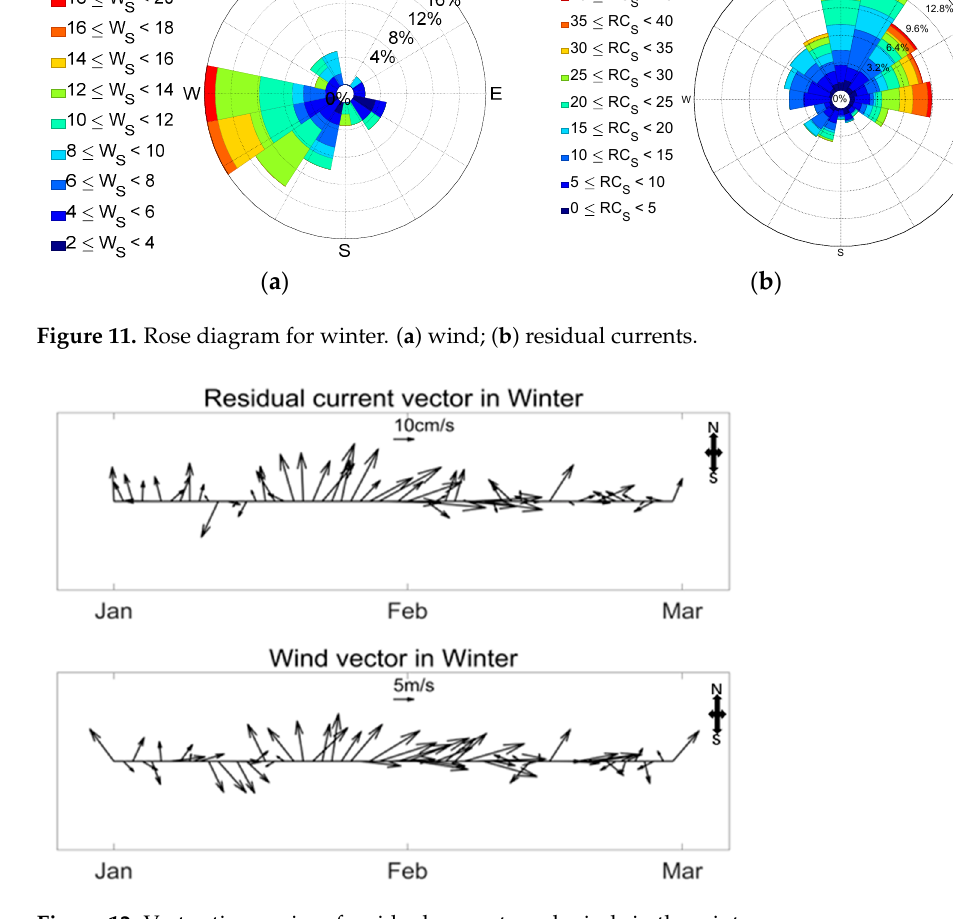
Figure 12. Vector time series of residual currents and winds in the winter.